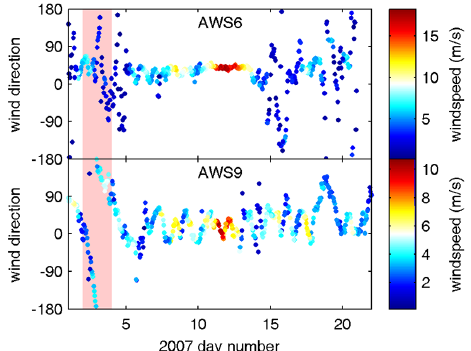
Figure 4. Wind speed and direction of automatic weather stations AWS6 and AWS9 (see Fig. 1 for their position) for the first 22 days of 2007. The storm event that destroyed the camp (Fig. 3) occurred during the pink shaded period, when winds were low at both AWSs. A synoptic storm occurred around 12 January, when conditions in the SBB valley were calm. Table 1. Physical parameter values used in the simulations. Fluid parameters were obtained for dry air at standard atmospheric pres- sure for a temperature of 243.15K.